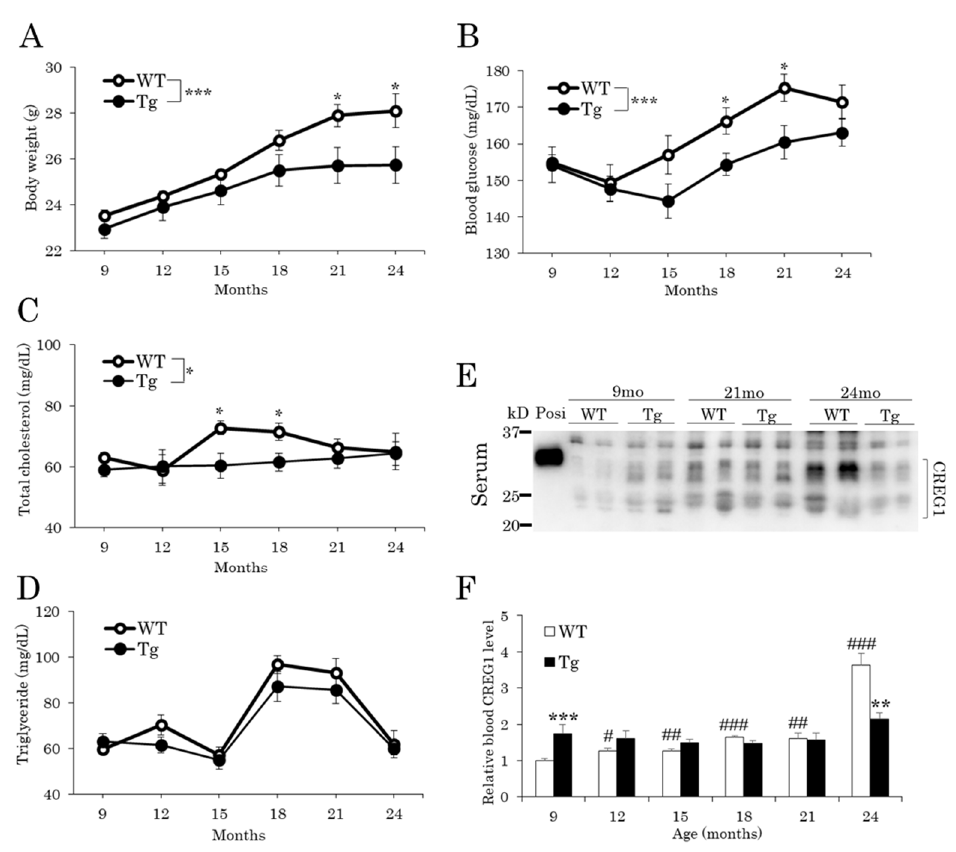
Figure 1. Changes in body weight and blood levels of glucose, lipids, and CREG1 in aged mice. ( A ) Body weight. ( B ) Fed glucose levels. ( C ) Total cholesterol levels. ( D ) Triglyceride levels. ( E ) Western blotting of CREG1 in serum. Positive control (Posi): mCREG1-MH [21]. A representative image is shown. ( F ) Relative CREG1 level in ( E ). Data are means ± SEM ( n = 13 for A and B , n = 8 for ( C – F ) * p < 0.05, ** p < 0.01, *** p < 0.001 vs. wild type (WT) at the same time point; # p < 0.05, ## p < 0.01, ### p < 0.001 vs. 9 months in the same genotype.